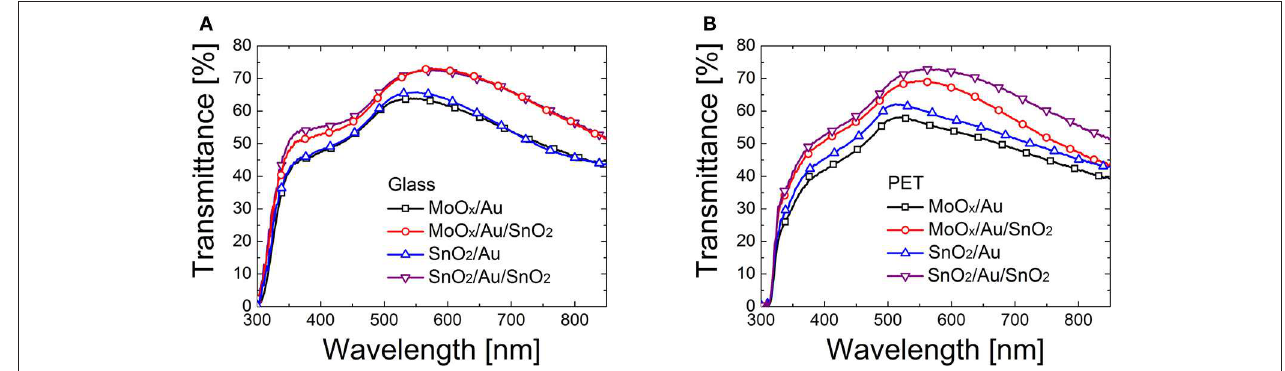
FIGURE 3 | Transmittance of dielectric/metal and dielectric/metal/dielectric electrodes based on MoO x (18nm)/Au (10nm), MoO x (18nm)/Au (10nm)/SnO 2 ( ∼ 15nm), SnO 2 ( ∼ 25nm)/Au (10nm), and SnO 2 ( ∼ 25nm)/Au (10nm)/SnO 2 ( ∼ 15nm) multilayers deposited on (A) glass and (B) PET.